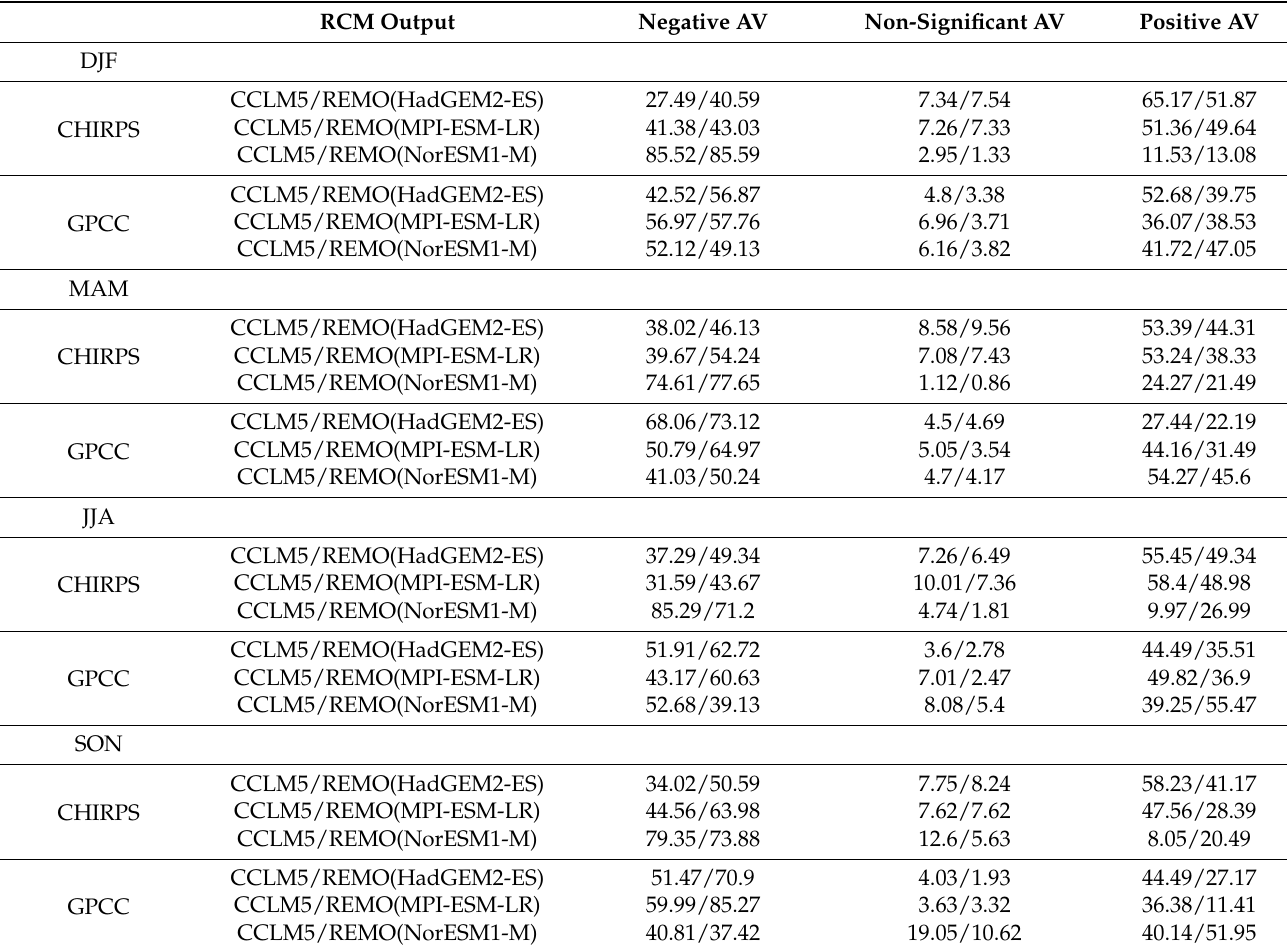
Table 3. Added value coverage in percentage for Africa’s land grid points at 10% significance